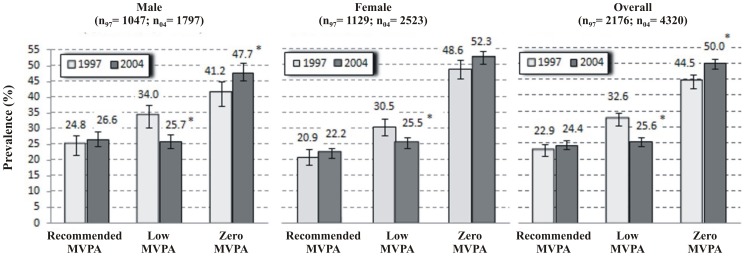
Changes in the prevalence of moderate to vigorous physical activity levels by sex.Results of prevalence were standardized by age using the direct method. The error bars represent the 95% confidence interval.